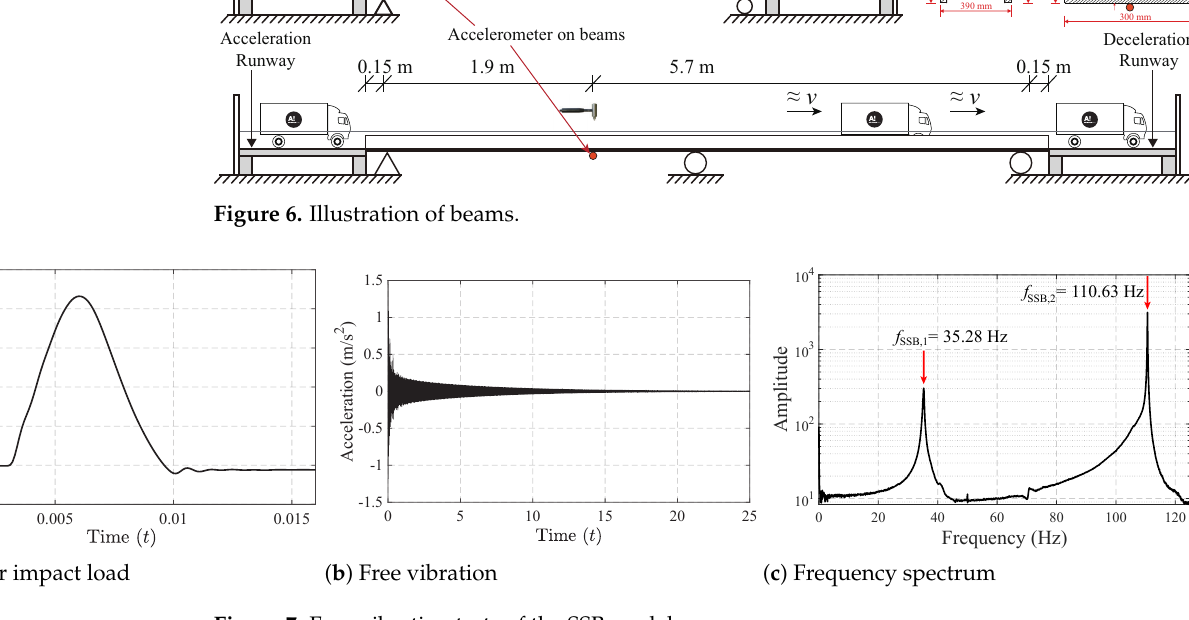
Figure 7. Free-vibration tests of the SSB